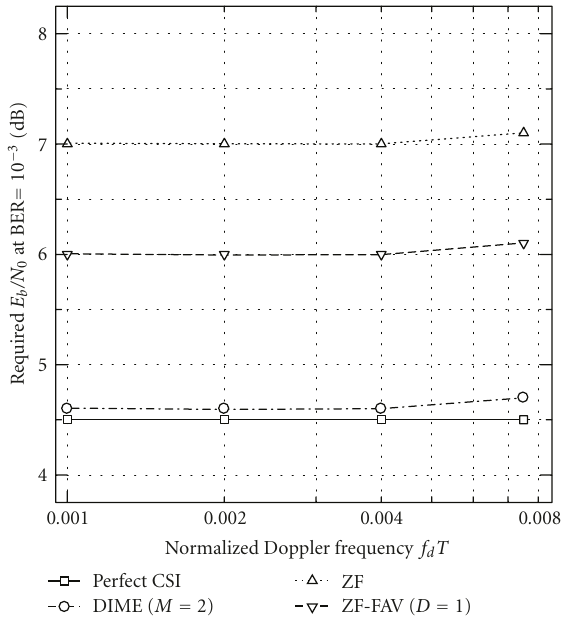
Figure 10: Required E b /N 0 performance versus normalized Doppler frequency with σ/T = 0 . 043